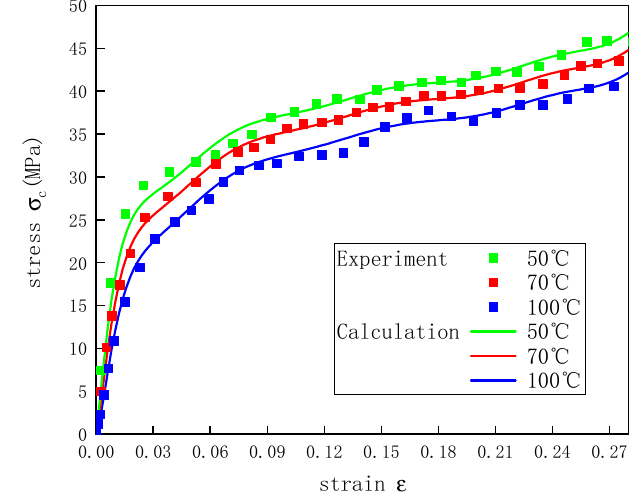
Figure 14. Stress–strain curves of UHMWPE at a strain rate of 3300 s − 1 and different temperatures.